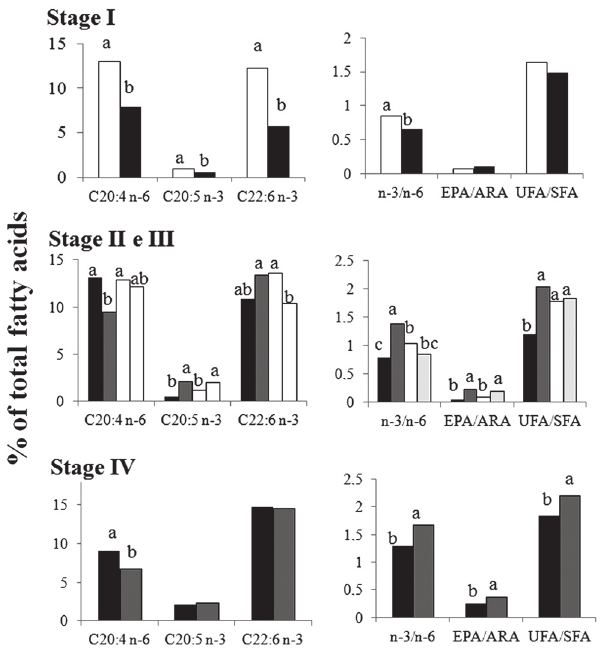
Fig. 3. Composition of fatty acids 20:4 n-6 (ARA), 20:5 n-3 (EPA) and 22:6 n-3 (DHA) and n-3/n-6, EPA/ARA relations and unsaturated fatty acids (UFA)/ saturated fatty acids (SFA) observed in Rhamdia quelen ovaries captured in different seasons: spring (dark gray), summer (black), winter (light gray) and autumn (white), and grouped according to their gonadal maturation stage (GMS) Immature = I, GMS II and III = GMS in maturation and GMS IV = Mature. 1 Different letter for the same fatty acid or fatty acids relation indicate significant differences at a significance level of 5%. 2 In winter females in stages of gonadal maturation I and IV, in spring females in stage of gonadal maturation I and in fall females in stage of gonadal maturation IV were not